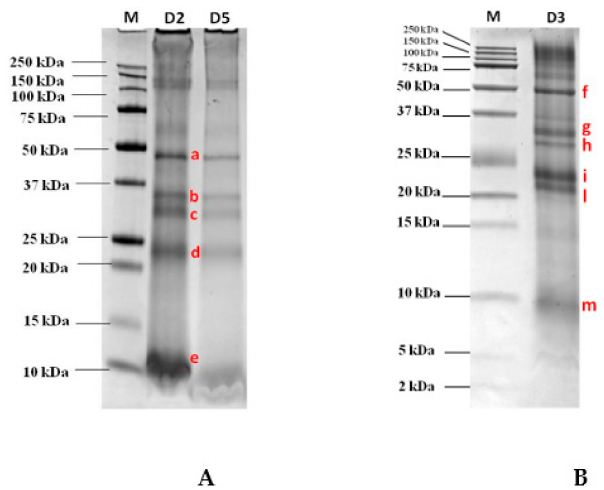
Figure 1. Separation on AnykD TM gel (Tris-glycine PAGE) and Tris-tricine 16.5% gel (Tris-tricine PAGE) of a goji berry (GB) protein extract loaded at several dilutions. ( A ) 1:2 (D2) corresponding to 105 µ g of proteins, 1:5 (D5) corresponding to 60 µ g of proteins; ( B ) 1:3 (D3) corresponding to 120 µ g of proteins) after staining with Comassie blue. Bands submitted to in-gel tryptic digestion for further mass spectrometric analysis, were marked with letters (a–e, ( A ) and f–m, ( B